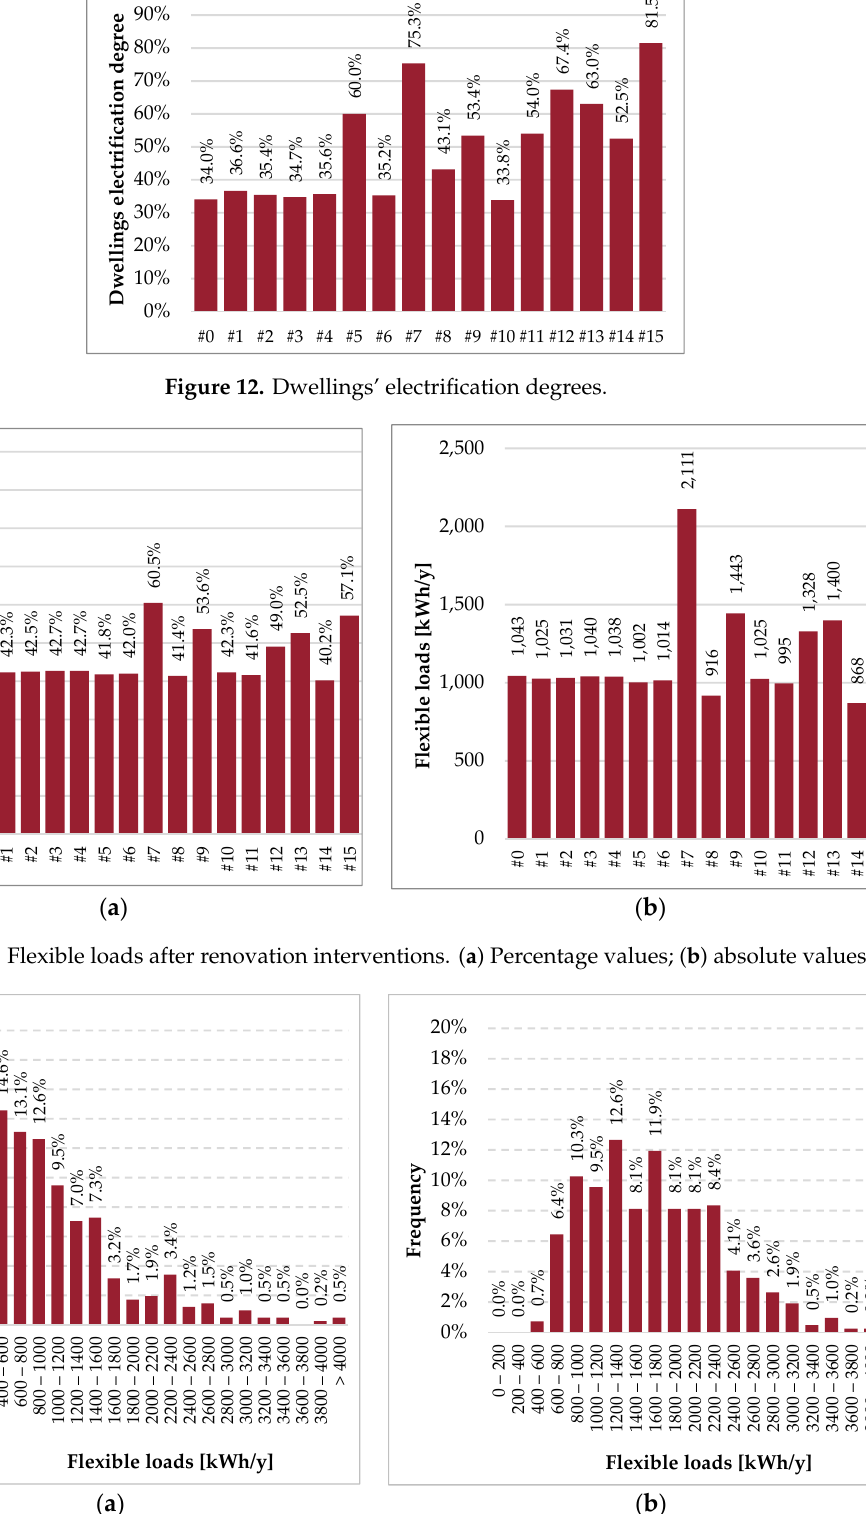
Figure 12. Dwellings’ electrification degrees.